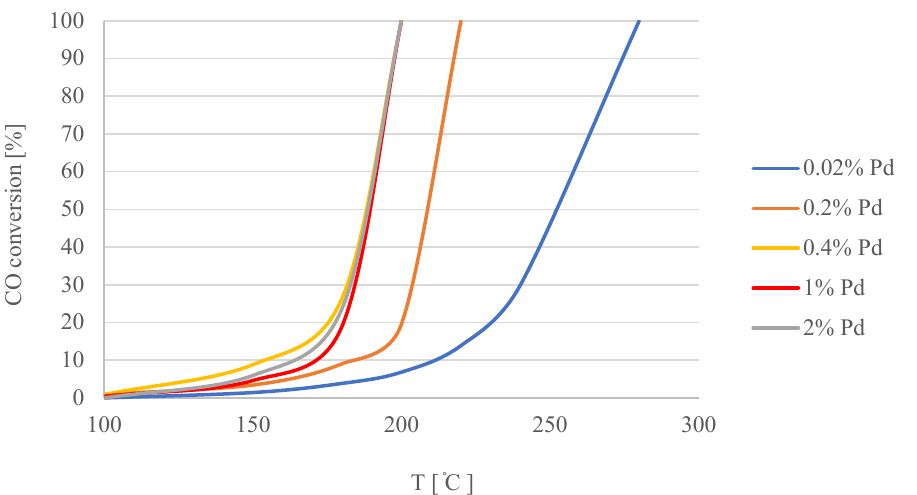
9 of 18 Figure 6. Adsorption of palladium on the surface of the TiO 2 /Ti support. The activity of the catalysts was tested in the presence of a mixture of synthetic air and 5% CO. The tests were continued until no CO was present in the outlet gas from the